Question: Reading the figure, is the described quantity rising or falling?
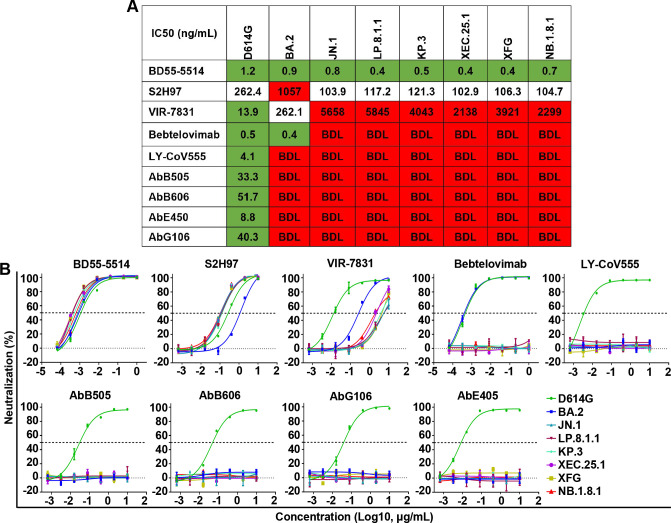
Answer: increasing